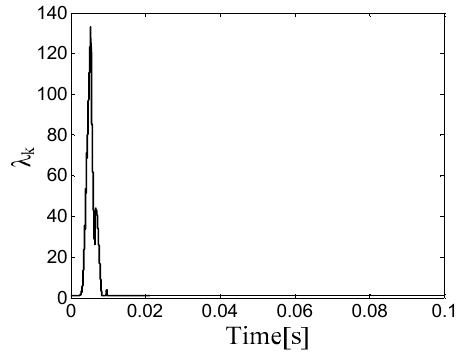
Figure 18. Fading factors of parameters disturbance.